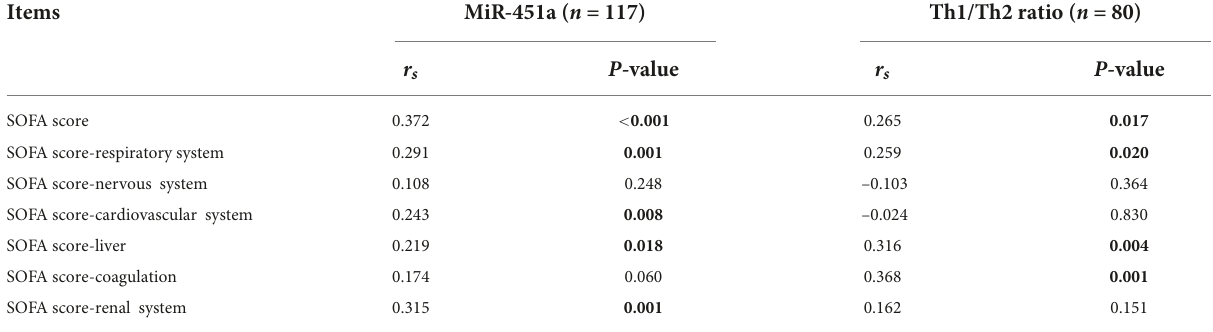
TABLE 2 Correlation of miR-451a and the Th1/Th2 ratio with the SOFA score in patients with sepsis.